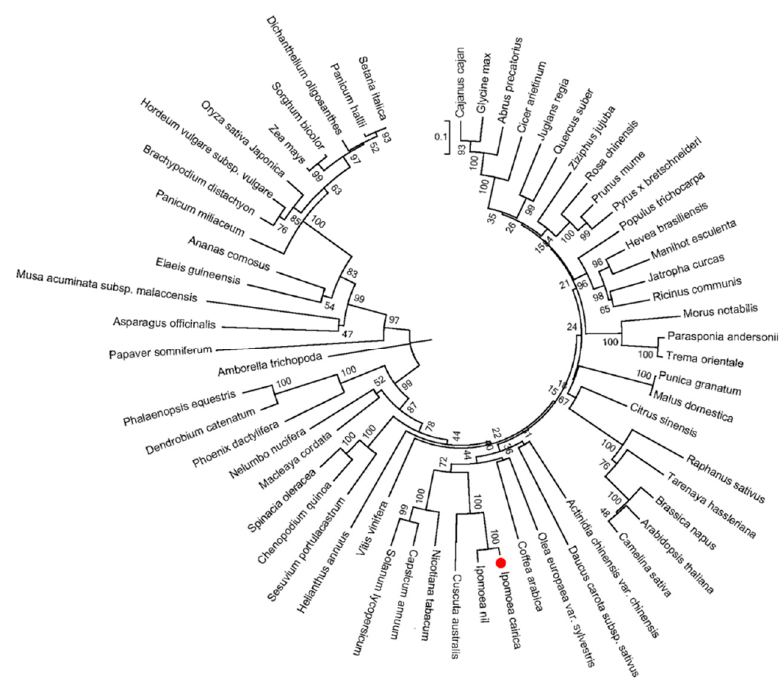
Figure 2. Phylogenetic tree of IcSRO1 and other SRO proteins revealed that IcSRO1 had a close relationship with the predicted protein products of Ipomoea nil . The tree was constructed by MEGA 6.0 software, based on alignment of complete protein sequences. The red dot indicates IcSRO1 protein.